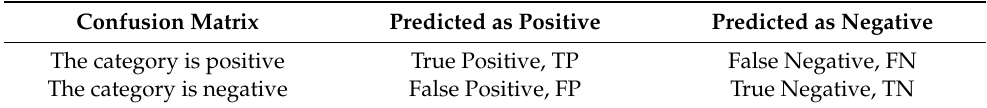
Table 3. Example of a dichotomous confusion